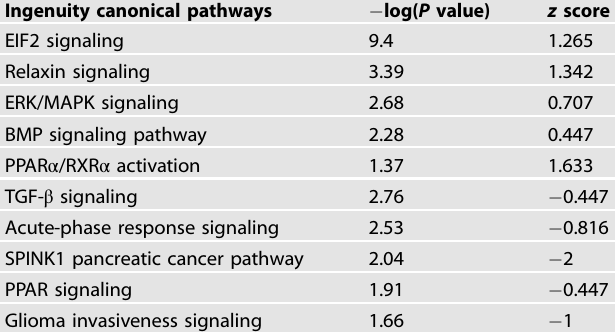
Table 2. Canonical signaling pathways are